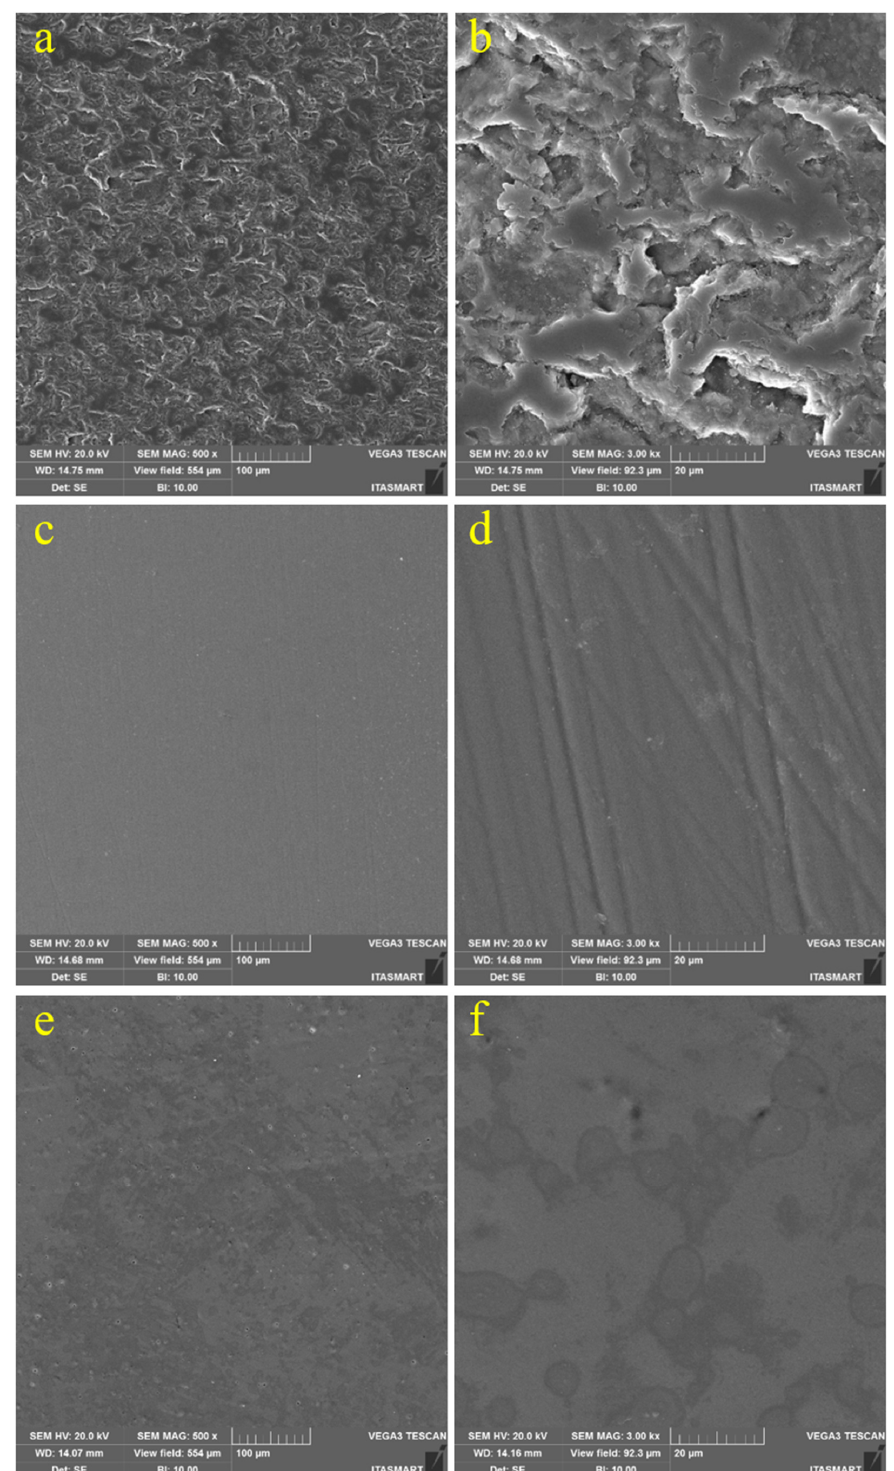
Figure 5. SEM images before the surfaces etching: ( a , b ) ZLS without crystallization firing, ( c , d ) ZLS with crystallization firing, and ( e , f ) LD with crystallization firing.